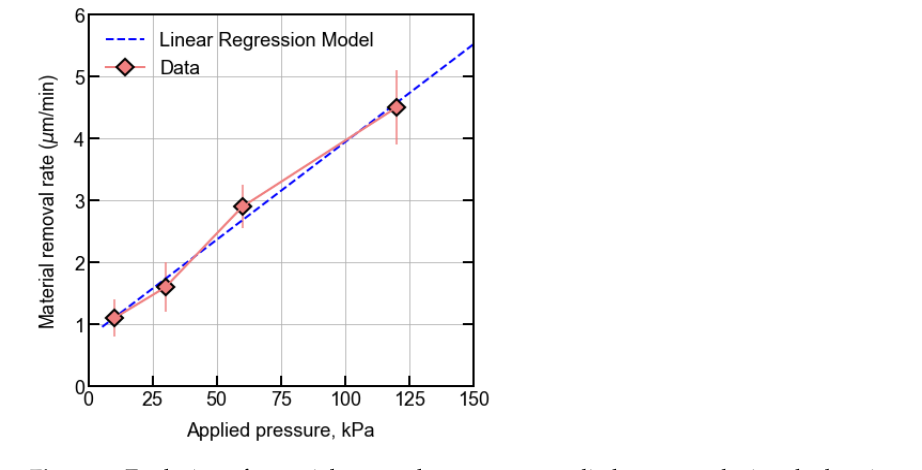
Figure 5. Evolution of material removal rate versus applied pressure during the lapping step.